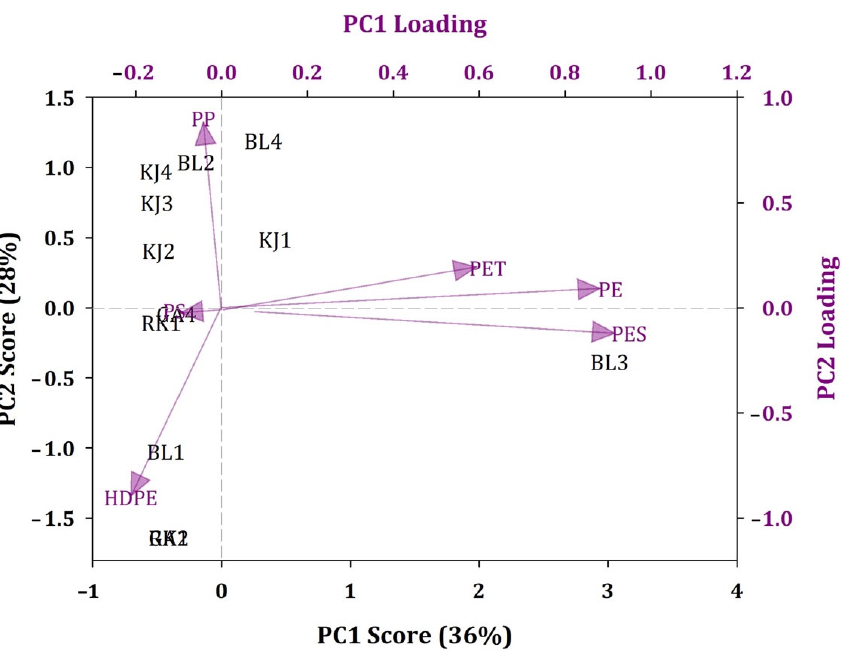
Figure 4. Principal component analysis score and loading plots of the distribution of MPs in the sediments of East Surabaya, Indonesia.